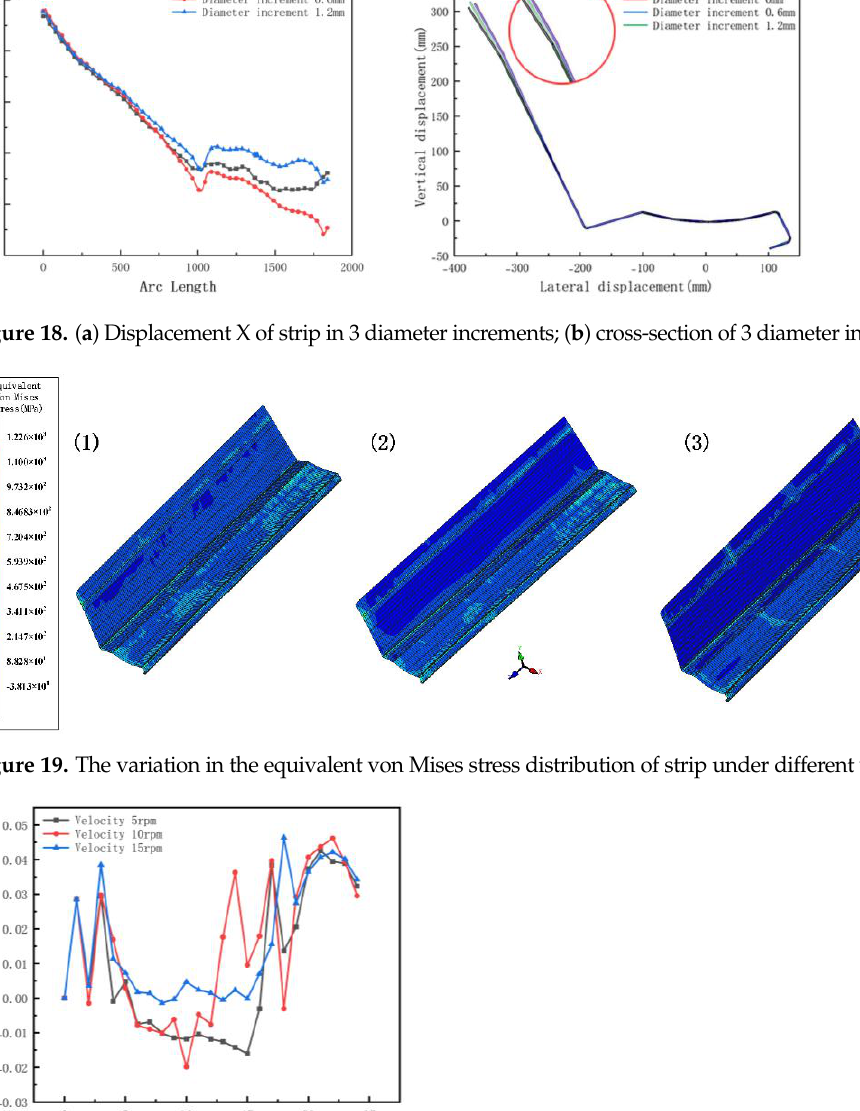
Figure 20. Longitudinal strain of strip in 3 velocities.